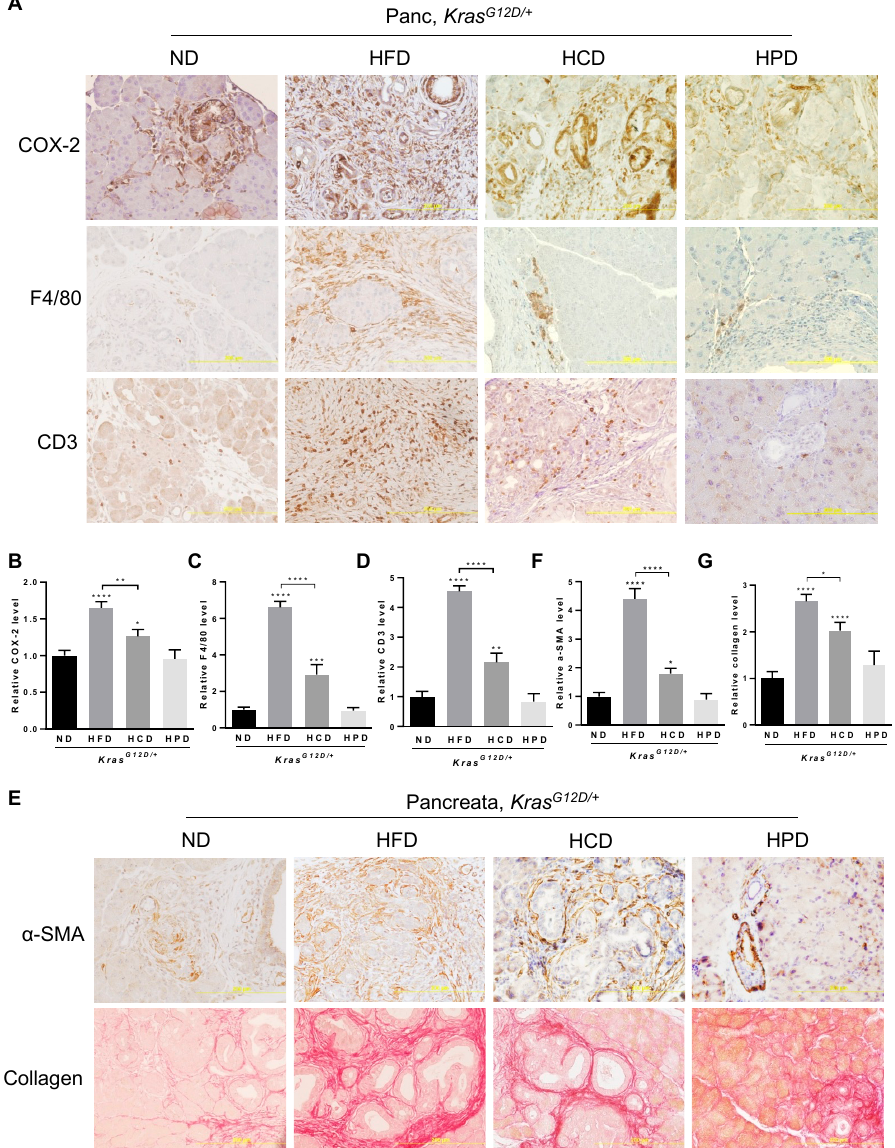
Figure 2. Effects of different macronutrient diets on oncogenic KRAS-mediated pancreatic inflammation and fibrosis in mice. ( A ) IHC staining of the pancreas from the Kras G12D/+ mice after 10-week ND, HFD, HCD, or HPD treatment with antibodies against COX-2, F4/80, or CD3. Magnification: 200×. ( B – D ) Quantification of each indicated staining in ( A ) with Fiji ImageJ software by measuring the integrated density (IOD) and area. ( E ) IHC staining of α -SMA (upper panel) and Sirius Red staining of collagens (lower panel) in pancreatic sections from Kras G12D/+ mice after 10-week ND, HFD, HCD, or HPD treatment. Magnification: 200×. ( F , G ) Quantification of each indicated staining in ( E ) with Fiji ImageJ software by measuring the integrated density (IOD) and area. *, **, *** and ****, p -value < 0.05, 0.01, 0.001 and 0.0001, respectively.